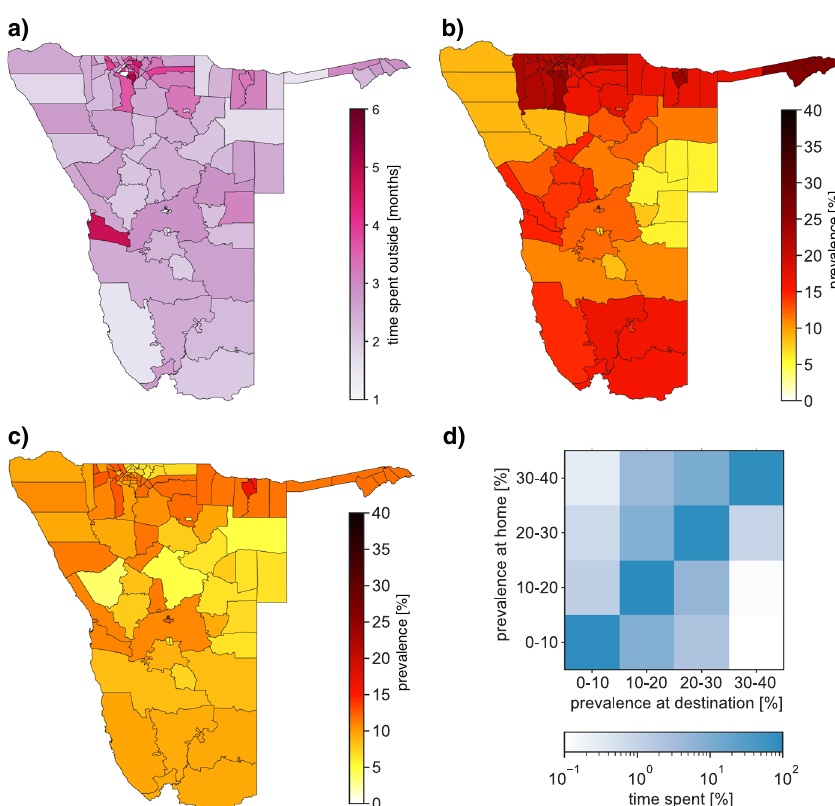
Fig. 2 Spatial relationships for mobility and HIV prevalence. a Cartographic map showing the average proportion of time (over a year: 2010 – 2011) residents spent outside their home constituencies. b HIV prevalence map showing geographic variation in prevalence in women (15 – 49 years old) at the level of the constituency in 2013. c HIV prevalence map showing geographic variation in prevalence in men (15 – 49 years old) at the level of the constituency in 2013. d Matrix showing the proportion of time (over a year) that men in Namibia spent in each prevalence “ class ” , as a function of the prevalence class of their home constituency. Prevalence refers to prevalence in women. The matrix is color-coded to show the fraction of time spent in the destination constituency. A logarithmic scale is used, ranging from 0.1 to 100%.